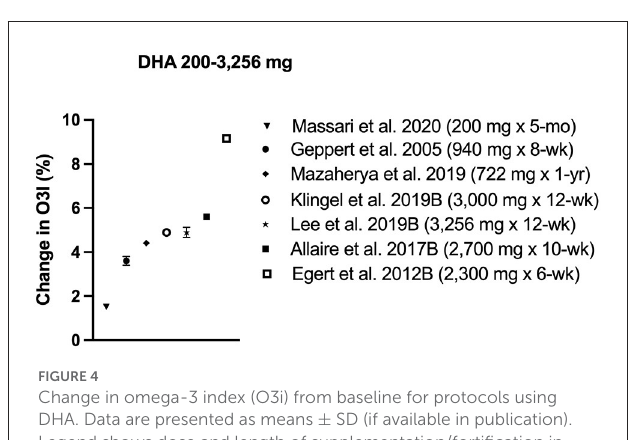
FIGURE4 Change in omega-3 index (O3i) from baseline for protocols using DHA. Data are presented as means ± SD (if available in publication). Legend shows dose and length of supplementation/fortification in